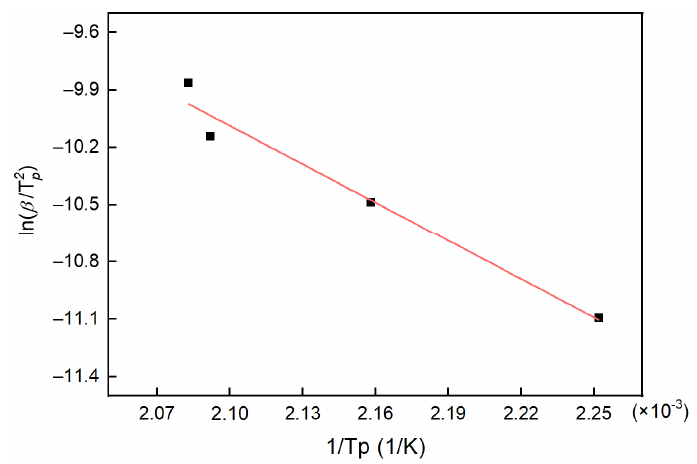
Figure 3. The fitting line based on the Kissinger equation. Table 1. DSC data at different heating rates.